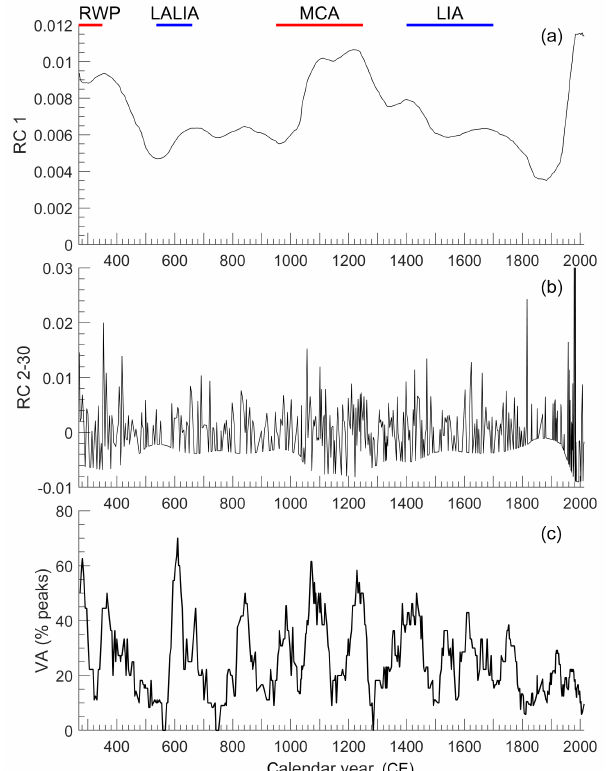
Figure 5. Tunu ice core vanillic acid analyzed by singular spectrum analysis (SSA) and peak detection showing centennial-scale vari- ability. (a) Low-frequency variability in Tunu vanillic acid recon- structed using component 1 of the SSA; (b) higher-frequency vari- ability in Tunu vanillic acid reconstructed using SSA components 2–30, excluding component 1; (c) peaks detected in the higher- frequency Tunu vanillic reconstruction (components 2–30), shown as the fraction of ice core samples exceeding a peak threshold (75th percentile) in a 40-year running window. The horizontal lines at the top show the Roman Warm Period (RWP), Late Antique Little Ice Age (LALIA), Medieval Climate Anomaly (MCA), and the Little Ice Age (LIA) (Büntgen et al., 2016; Mann et al., 2009; Wang et al., 2012).